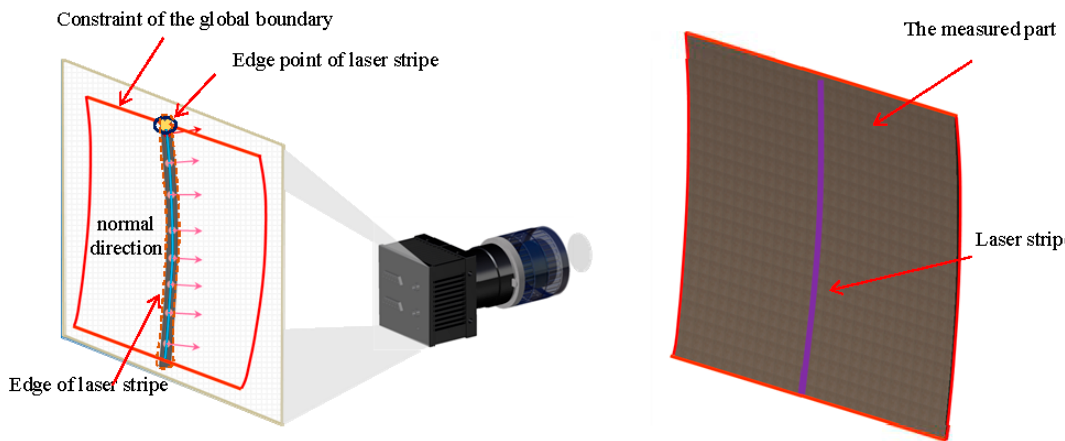
Figure 2. Schematic diagram of laser stripe capture.